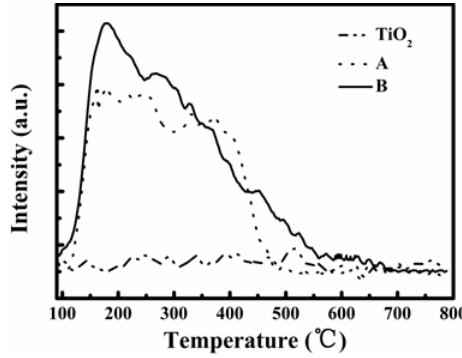
Figure 7. NH 3 -TPD profiles for catalysts A and B and TiO 2 support.